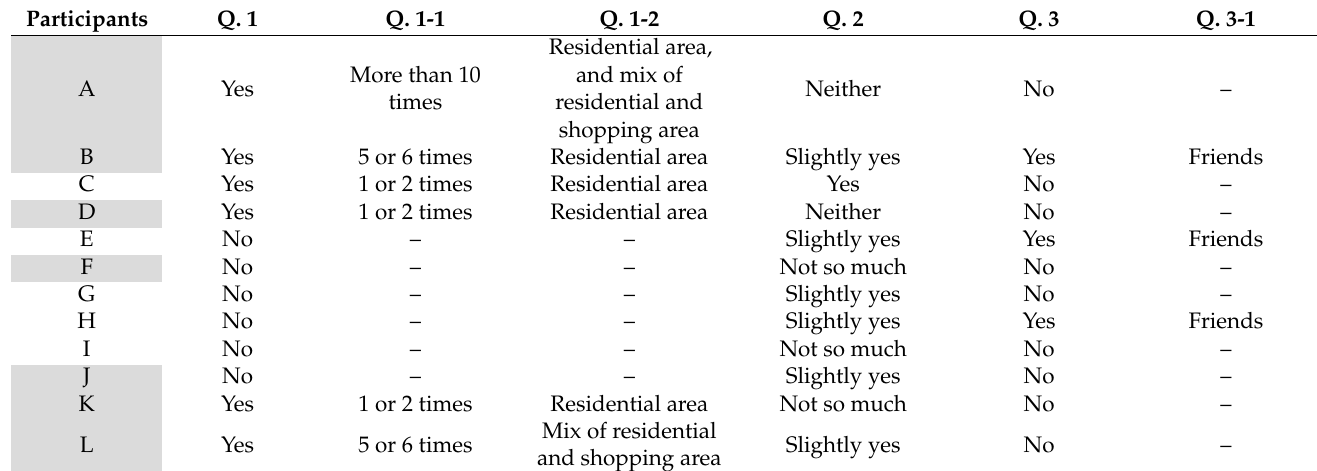
Table 5. Results of the follow-up survey conducted 1 month after the